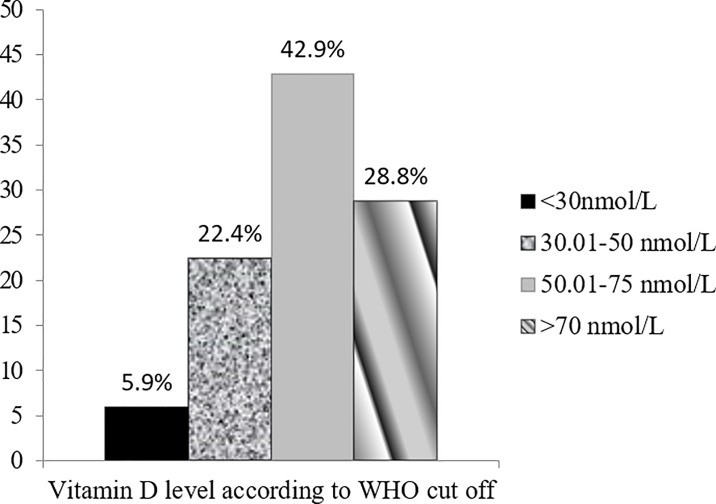
Distribution of vitamin D level in the population.